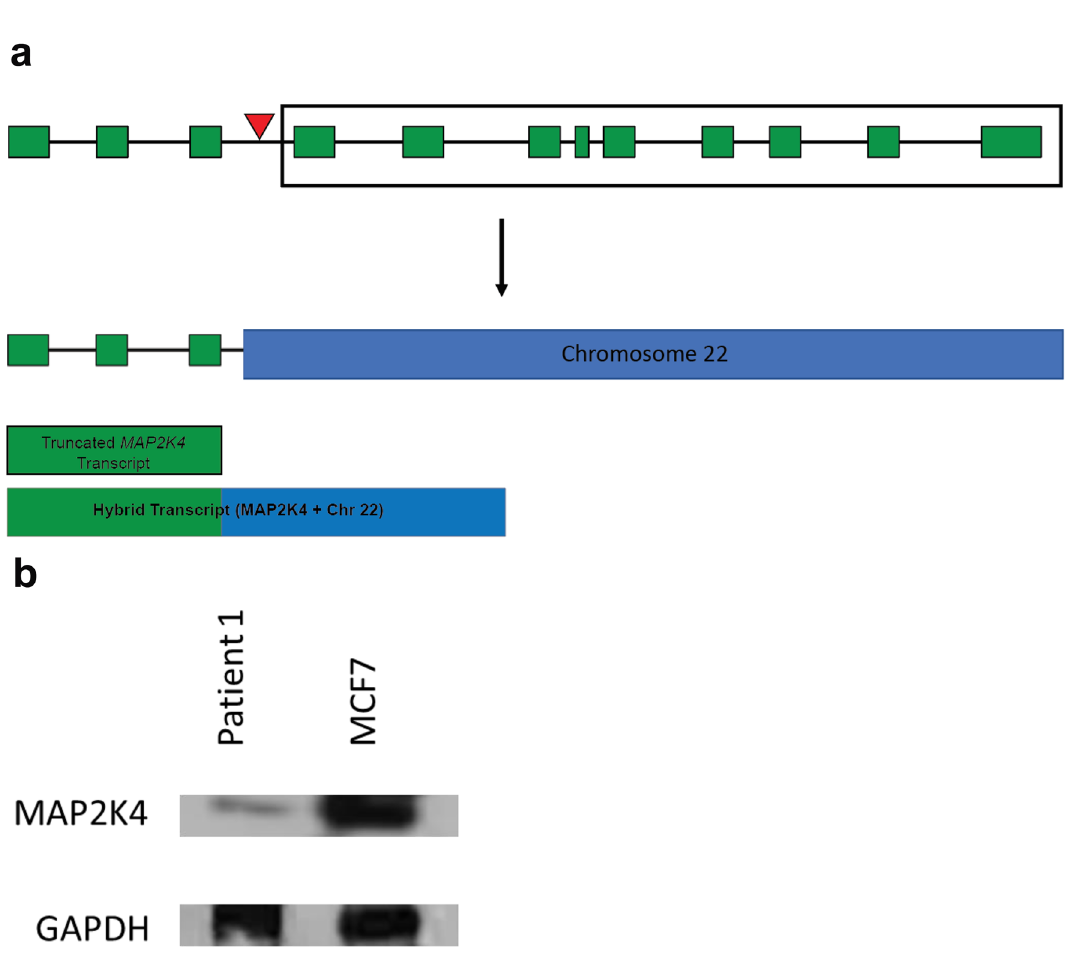
Figure 4. Translocation within MAP2K4 gene decreases protein production in Patient 1. ( A ) Schematic of the primary transcript of MAP2K4 . The exons of the transcript are shown as green boxes and the red triangle above MAP2K4 depicts the approximate location of the translocation. The translocation results in a truncation of MAP2K4, leaving only the first three exons remaining on Chromosome 17. The portion of MAP2K4 shown in the box is translocated to Chromosome 22. The translocation is depicted below the arrow. Truncated and hybrid transcripts are shown below the translocation. ( B ) Western blot of MAP2K4 in control MCF7 cells and ascites-derived cells from Patient 1. The control cells show clear expression of MAP2K4 , while the cells taken from Patient 1 show decreased production of the protein. GAPDH blotting was performed as a loading control. Uncropped images of the Western blot are shown in Supplemental Figure